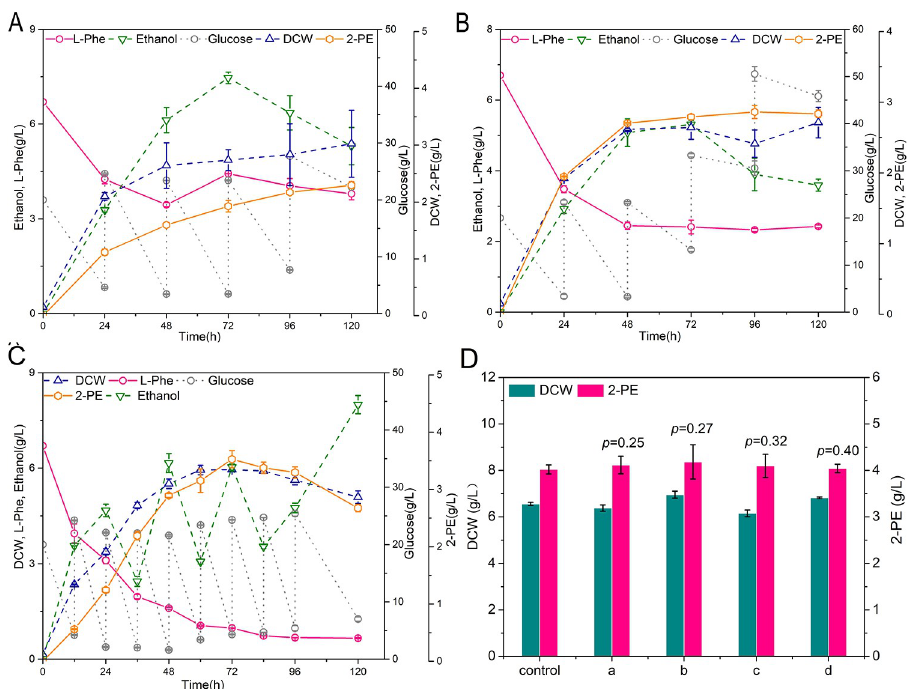
Fig 9. Optimization of 2-PE synthesis in metabolic engineered yeast strain RM27. (A) Fermentation view of JM00 with L-phenylalanine as the sole nitrogen. (B) Fermentation view of RM27 with L-phenylalanine as the sole nitrogen. (C) Fermentation view of RM27 in YSM medium with the addition of glucose every 12 h. (D) Fermentation view of RM27 in YSM medium with the addition of L-glutamate or α -ketoglutarate. (a) One mmol/L α -ketoglutarate was added to the medium at 24 h. (b) One mmol/L α -ketoglutarate was added to the medium every 24 h. (c) One mmol/L L-glutamate was added to the medium at 24 h. (d) One mmol/L L-glutamate was added to the medium every 24 h. Data are presented as the averages of the results of three independent experiments. Error bars show standard deviations. Statistical analysis was performed by using Student’s t-test (one-tailed; two-sample unequal variance; � p < 0.05, �� p < 0.01, ��� p <